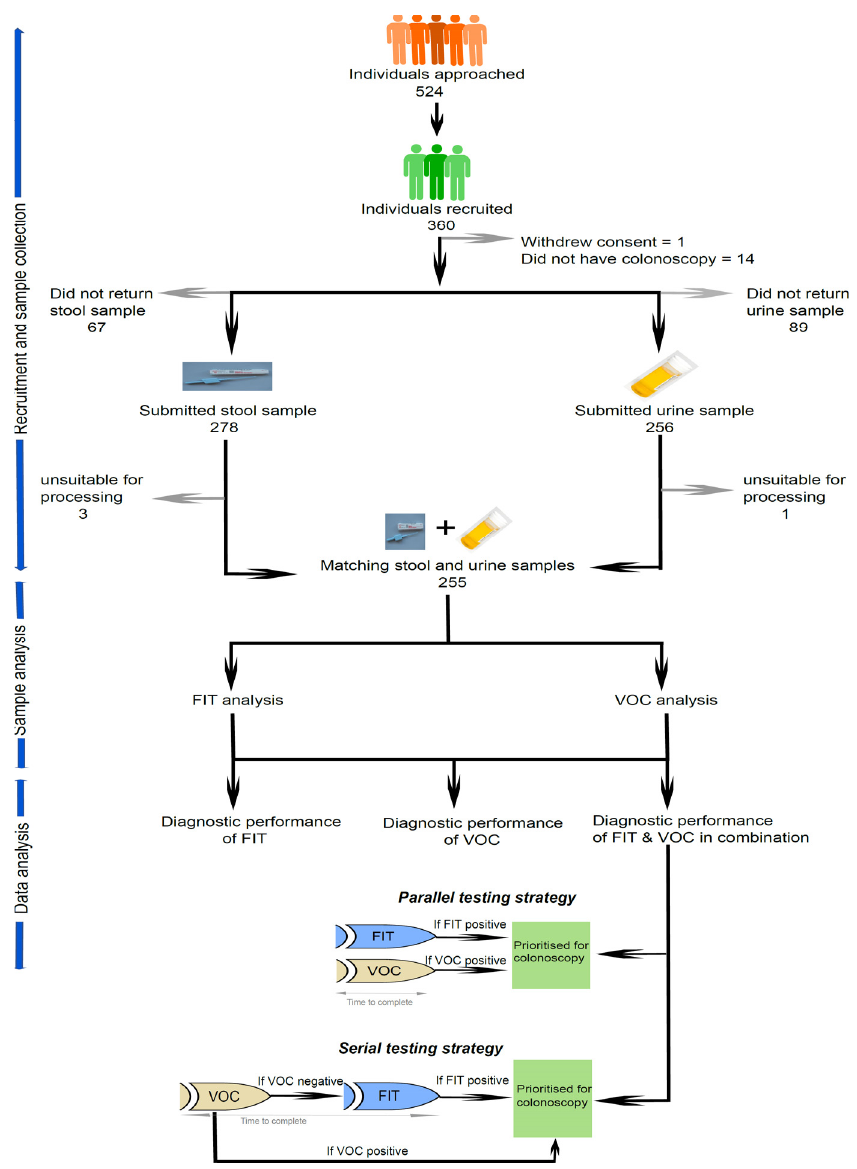
Figure 1. Participants flow through the study for the total number of individuals approached and recruited who met the inclusion